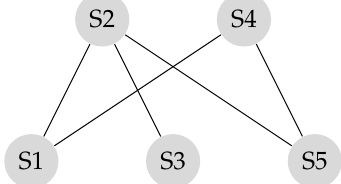
Figure 2. Bipartite graph corresponding to Figure